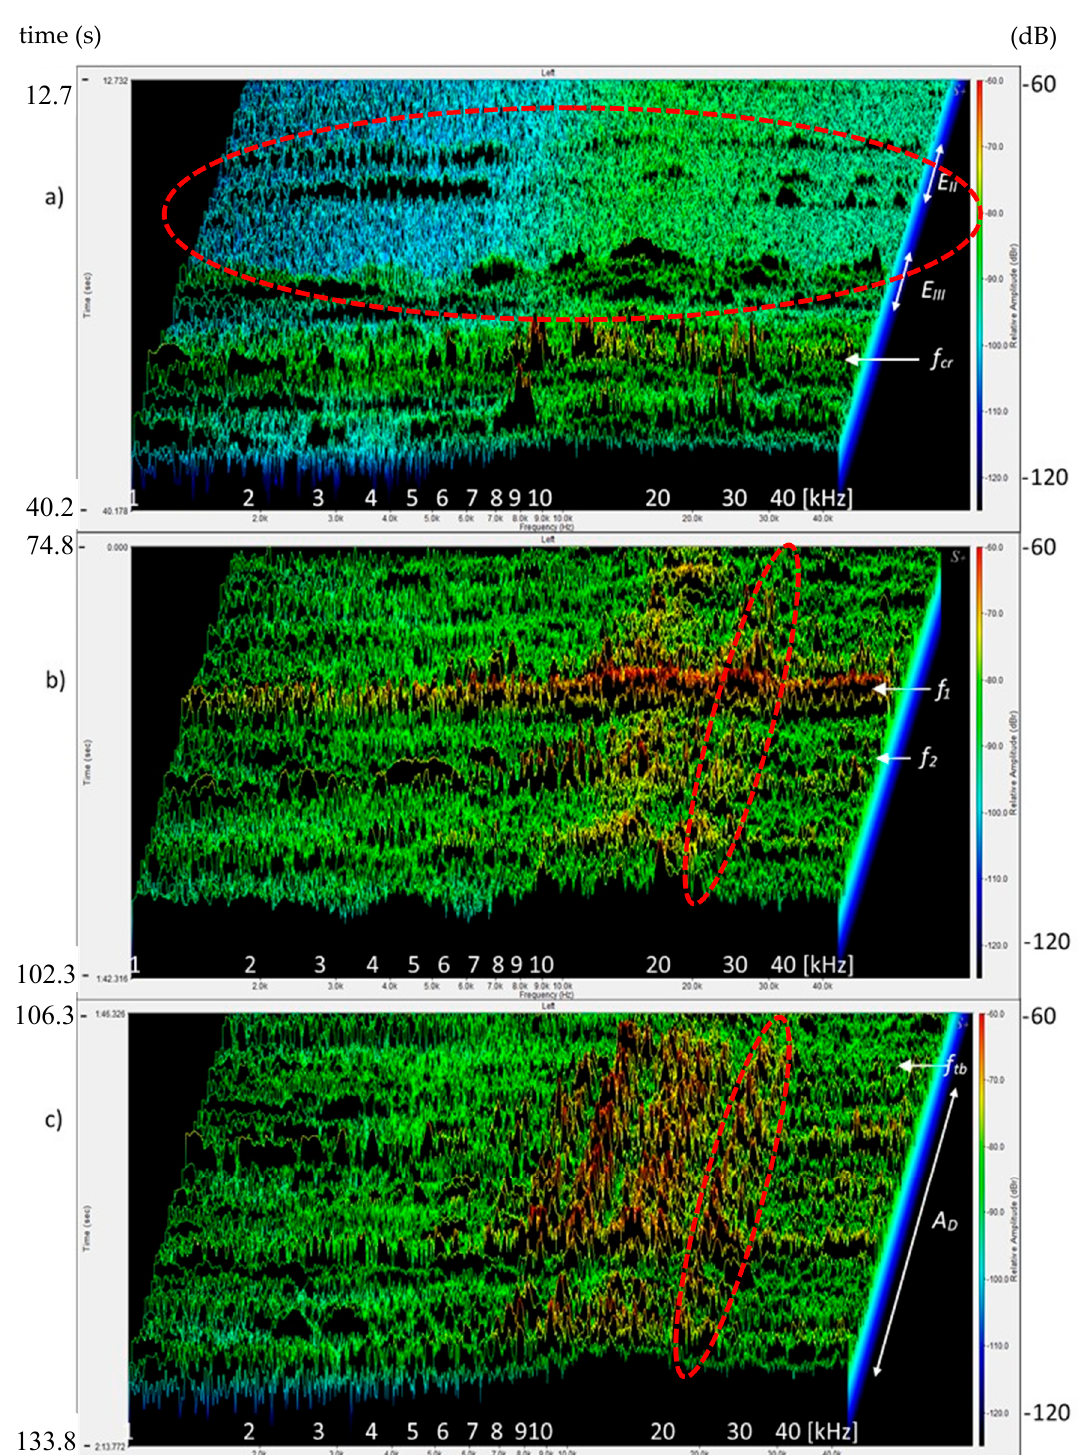
Figure 8 Composite sound spectra: (a) background, micro-events E II , E III , and f c , (b) event f 1 , (c) event Figure 8. Composite sound spectra: ( a ) background, micro-events E II , E III , and f c , ( b ) event f 1 , ( c ) event f tb and deflection control area A D . f tb and deflection control area A D